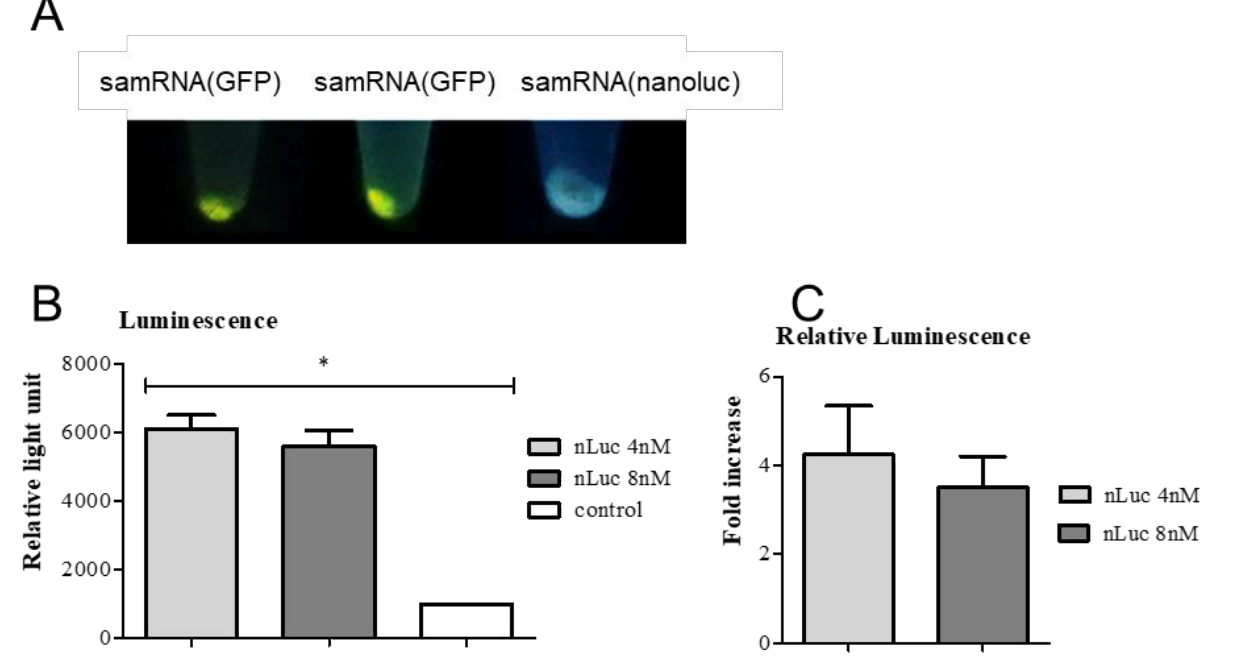
Figure 5. Quantification of GFP and Nano-Luciferase expression demonstrated their strong produc- tion in Vero cells. In ( A ), pellets from Vero cells transfected with replicons expressing either GFP or nanoluc are shown under UV light (48 h after transfection). The third sample was transfected with cationic liposomes containing nLuc replicons under the same conditions. ( B ) Luminescence activity of Vero cells transfected with nLuc replicon complexed with 4 nM or 8 nM of cationic liposomes compared with non-transfected cells (control). The luminescence from each sample was normalized regarding the volume of the sample and protein concentration from each one. p -values are given for one-way ANOVA where * represents p < 0.005. ( C ) Relative luminescence of Vero cells transfected with nLuc replicon in relation to non-transfected cells. The difference in luminescence between the two samples (with a higher and lower concentration of liposomes) was not statistically significant. All experiments were performed in triplicate. Error bars show the deviations from three technical